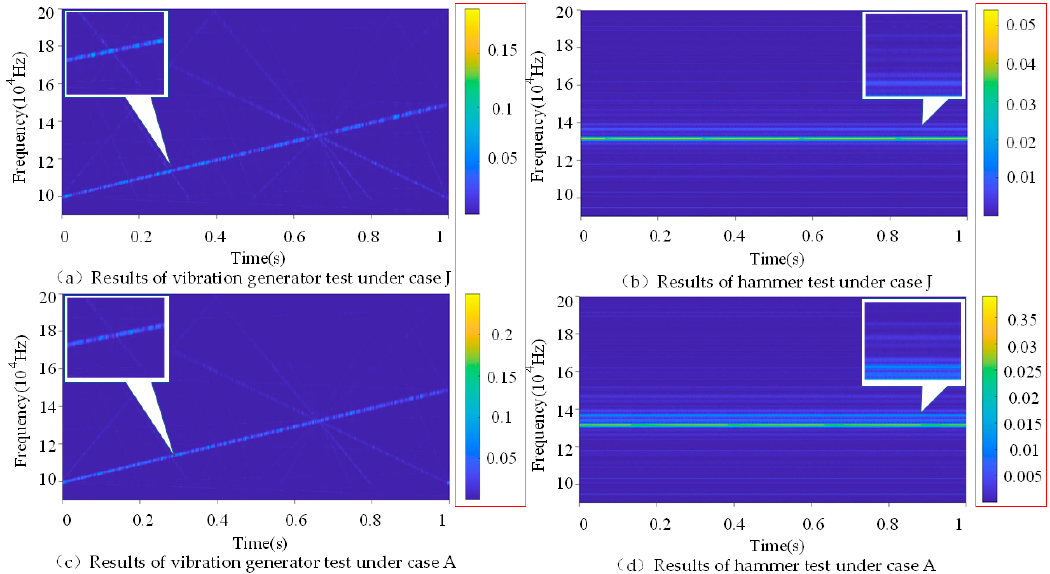
Figure 6. Time-frequency diagram obtained using different test methods excitation frequencies: ( a ) results of vibration generator test under case J; ( b ) results of hammer test under case J; ( c ) results of vibration generator test under case A; ( d ) results of hammer test under case A.